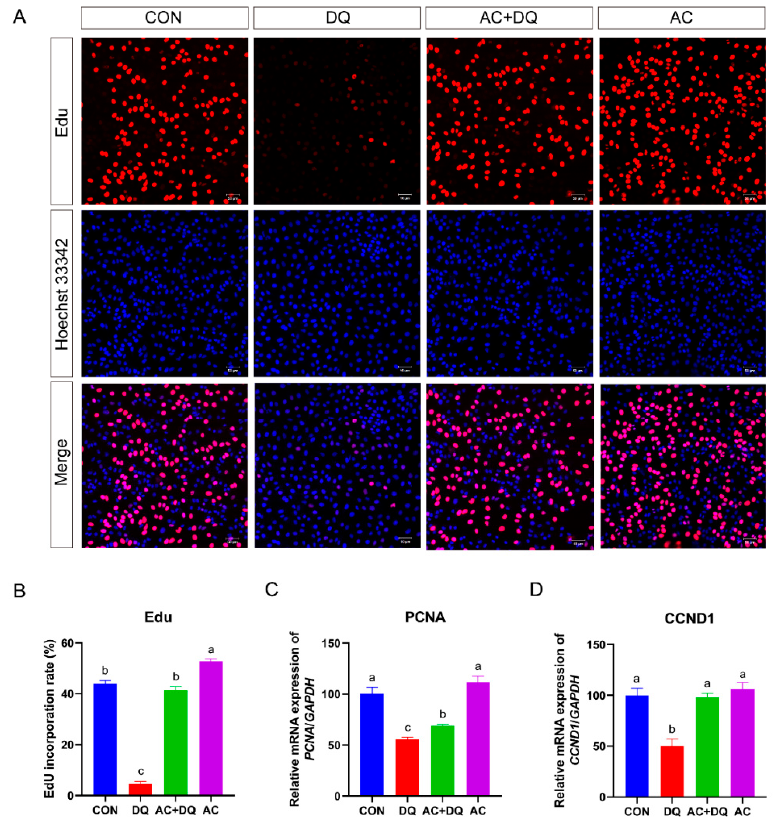
Figure 6. The effect of acidifiers on the proliferation of IPEC-J2 cells induced by diquat. ( A ) Edu staining of IPEC-J2 cells (magnification 10×, scale bar = 50 μ m). ( B ) Statistical results of the proportion of EdU-positive cells. ( C ) Relative mRNA level of PCNA gene. ( D ) Relative mRNA level of CCND1 gene. CON, cells without being treated; DQ, cells were only treated by 1150 μ M of diquat for 6 h; AC + DQ , cells were pretreated by 0.005% acidifier for 4 h and were then treated by 1150 μ M of diquat for 6 h. AC, cells were only treated by 1150 μ M of acidifier for 6 h. All values were represented as means ± SEM ( n = 6). Different superscript letters denote a statistically significant difference between groups ( p < 0.05), while same letters denote no significant difference.